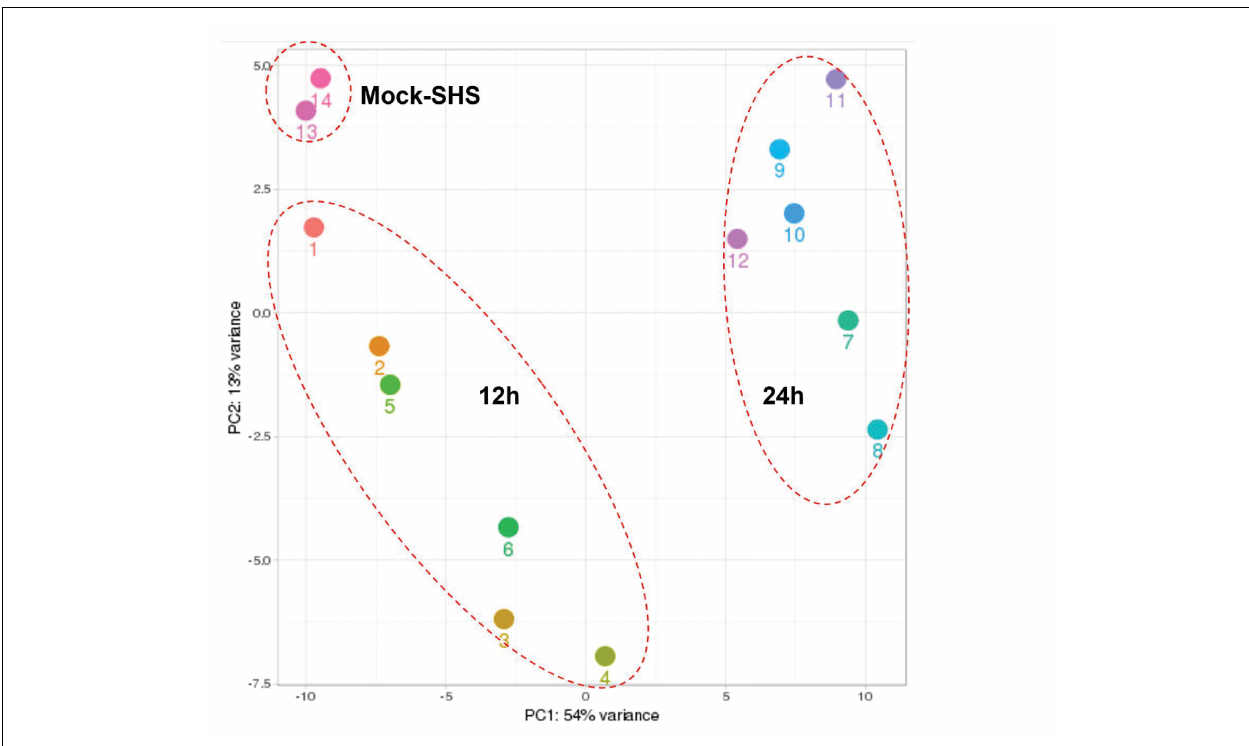
FIGURE 1 | Hierarchical clustering of miR expression. Analysis of overall read composition following RSV- or MeV-infection of SHS cells. Clustering is indicated by dashed circles. 12 h = 12 hpi; 24 h = 24 hpi. Samples 1–3 are 12 h MeV infection, samples 4–6 are 12 h RSV infection, samples 7–9 are 24 h MeV infection, samples 10–12 are 24 h RSV infected SHS cells and mock infected samples are samples 13 and 14. PCA involved all miR, differential expression profiles, and RSV and MeV time points (12 h vs. 24 h) to determine the derived variables known as principal components (PCs). Principal component 1 (PC1) was separated by time (hpi) while principal component 2 (PC2) was separated by infected vs.